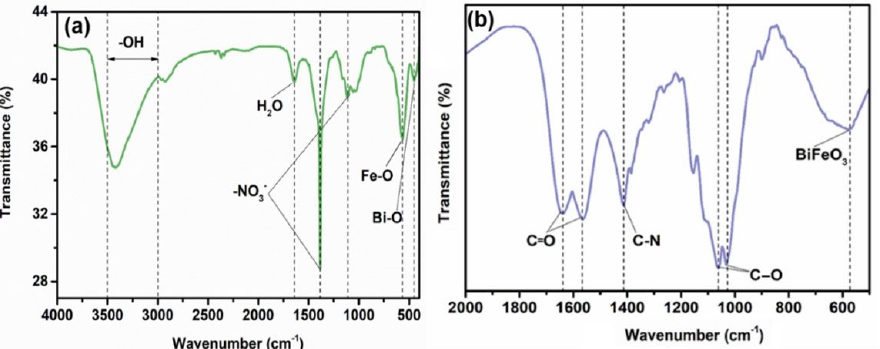
Figure 2. ( a ) FTIR spectrum of synthesized BFO and ( b ) FTIR spectrum of synthesized CBB.